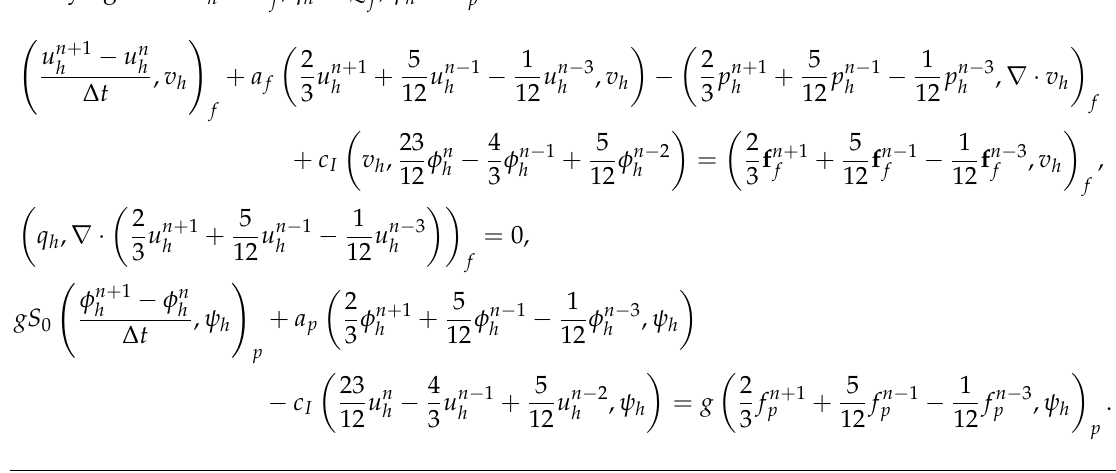
Algorithm 10 Third-order Adam–Moulton–Bashforth method (AMB3) Given ( u n − 3